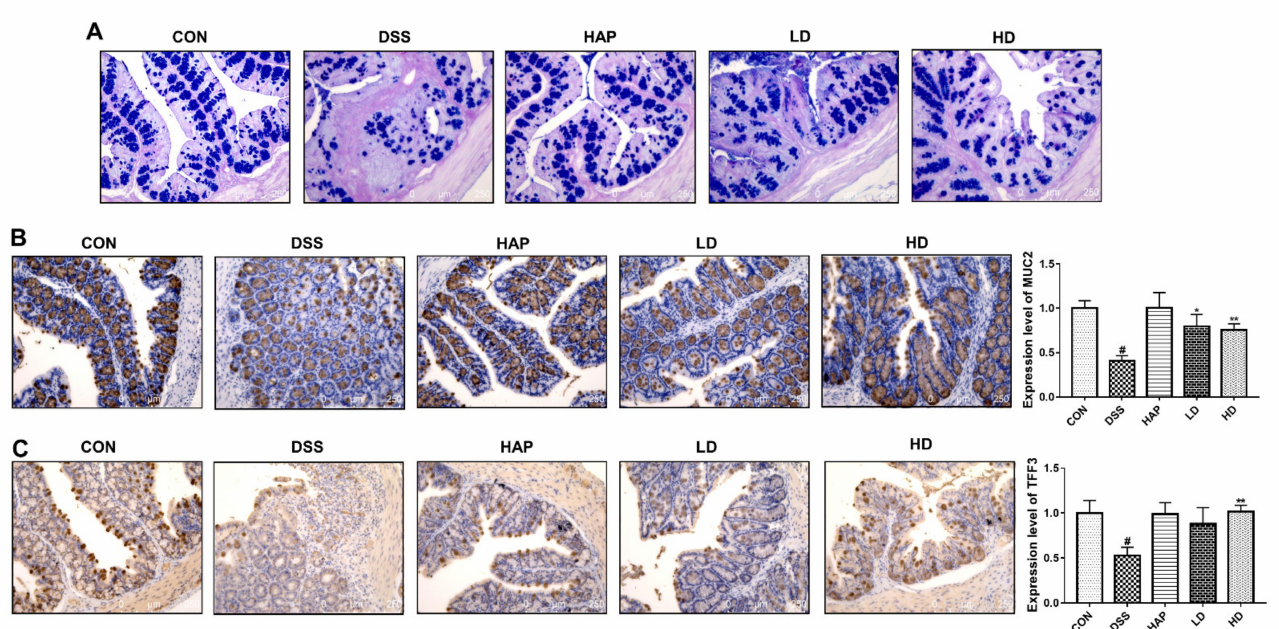
Figure 5. Effect of APE on the function of goblet cells: ( A ) Representative image of alcian blue/periodic acid-schiff (AB-PAS) staining at 20 × resolution. ( B ) The protein level of mucoprotein-2 (MUC2) was determined by immunohistochemistry. ( C ) The proteins level of trefoil factor 3 (TFF3) was determined by immunohistochemistry. n = 8 or 9. # p < 0.05 vs. CON group. * p < 0.05 vs. DSS group. ** p < 0.01 vs. DSS